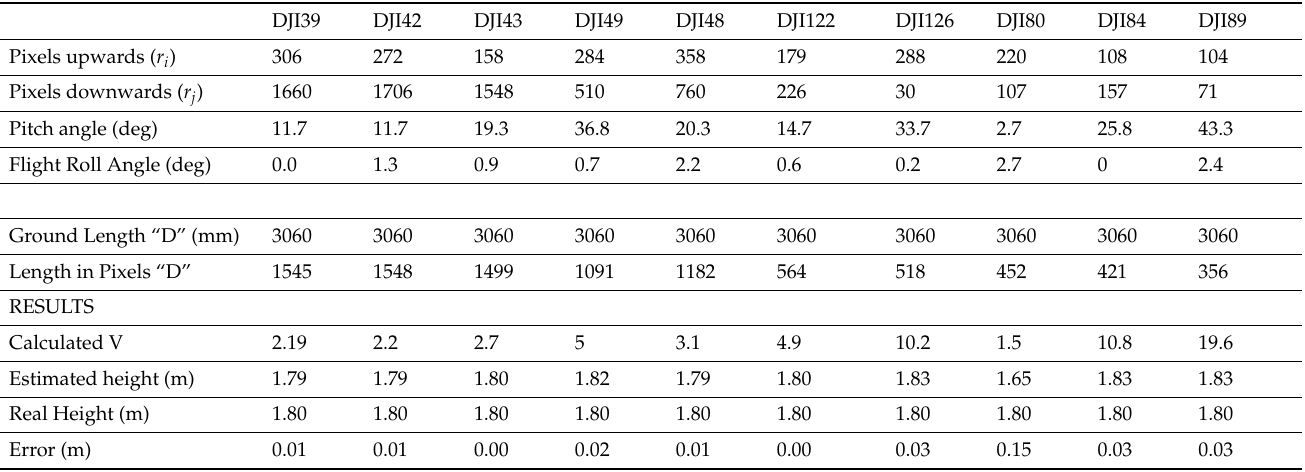
Table 3. Data collected during the Field Test 1 and results.